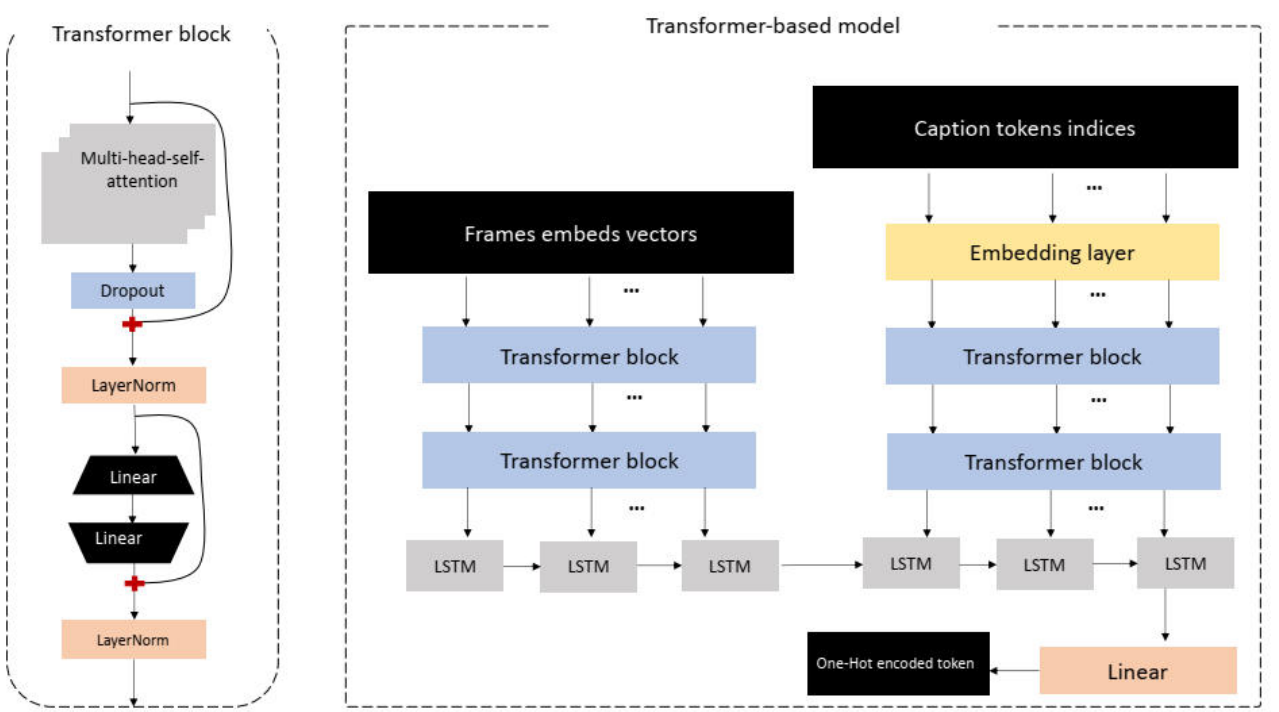
Figure 5. Left: the transformer block. Right: the proposed transformer-based model architecture.